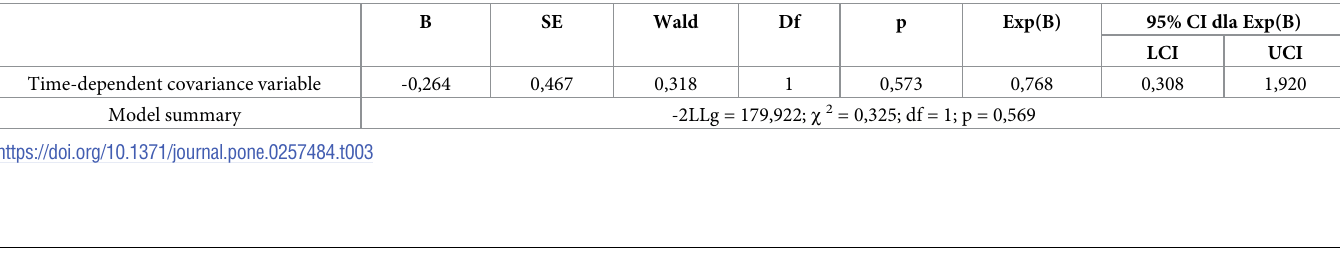
Table 3. Time to progression and experience of endocrine complications on nivolumab treatment. B